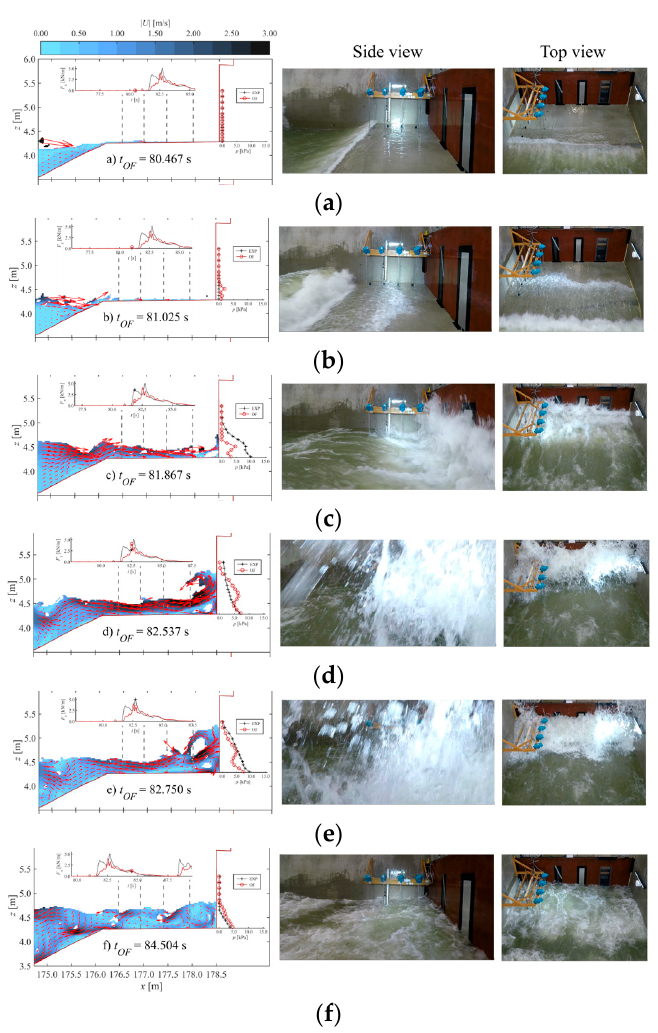
Figure 14. Snapshots of selected key time instants chronologically over the second main impact ( a – f ). See the caption of Figure 13 for further descriptions. Table 6. Description of the snapshots shown in Figure 13 (main impact 1) and Figure 14 (main impact 2). Figure Description Figure 13a Pre-impact of small overtopped wave. Pre-collision of large overtopped bore and small Figure 13b wave reflected from vertical wall. Collision of large overtopped bore and reflected Figure 13c small wave. Main Impact 1 Impact on vertical wall of high velocity spray from Figure 13d overturned bore. Figure 13e Dynamic impact of overturned bore on vertical wall. Quasi-static impact of overturned bore on vertical Figure 13f wall. Figure 14a Very small overtopped bore. Figure 14b Impact of small overtopped bore on vertical wall. Figure 14c Impact of large overtopped bore on vertical wall. Impact of large overtopped bore on vertical wall, Main Impact 2 Figure 14d continued. Impact of large overtopped bore on vertical wall, Figure 14e continued. Figure 14f Return flow of large bore reflected from vertical